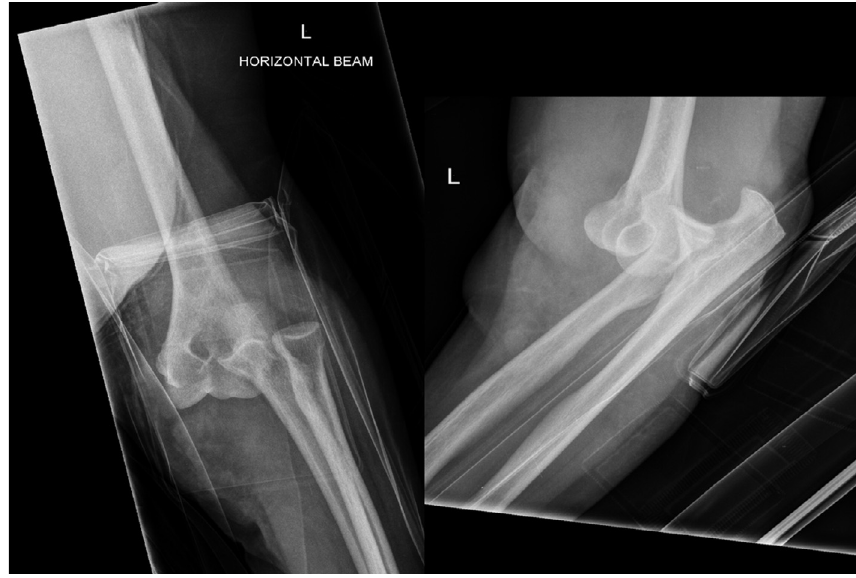
Figure 1. Elbow AP and lateral radiographs at presentation.